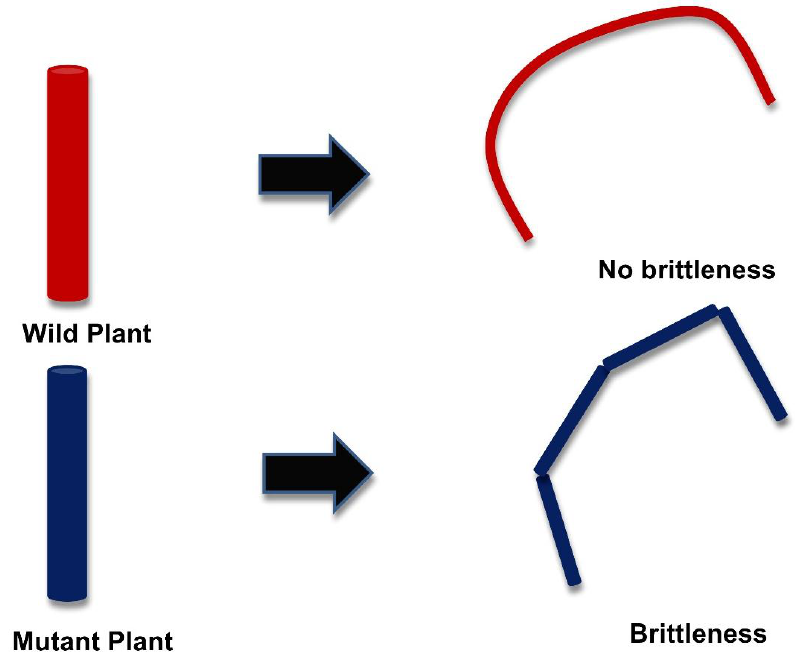
Figure 6. Wild and mutant plants showing similar agronomy traits, but brittleness was observed in the mutant plant after genetic